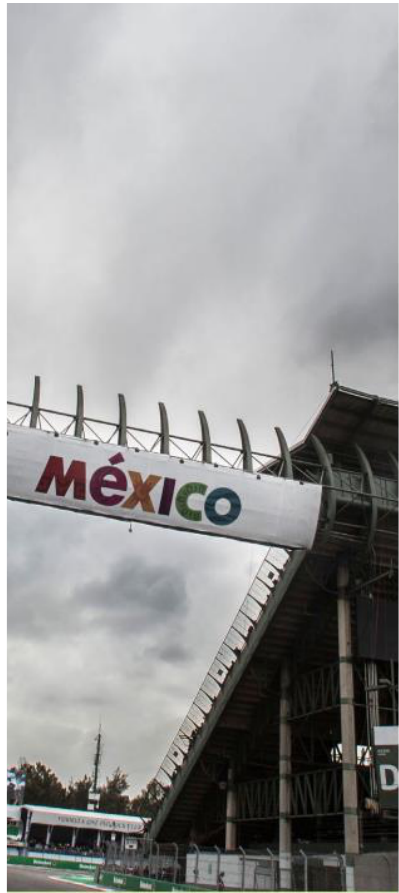
Figure 3. Foro Sol. Resource: https://www.turismo.cdmx.gob.mx/storage/app/media/Docs/Anuario%20estadistico%20Turismo%2020.pdf (accessed on 5 November 2022).